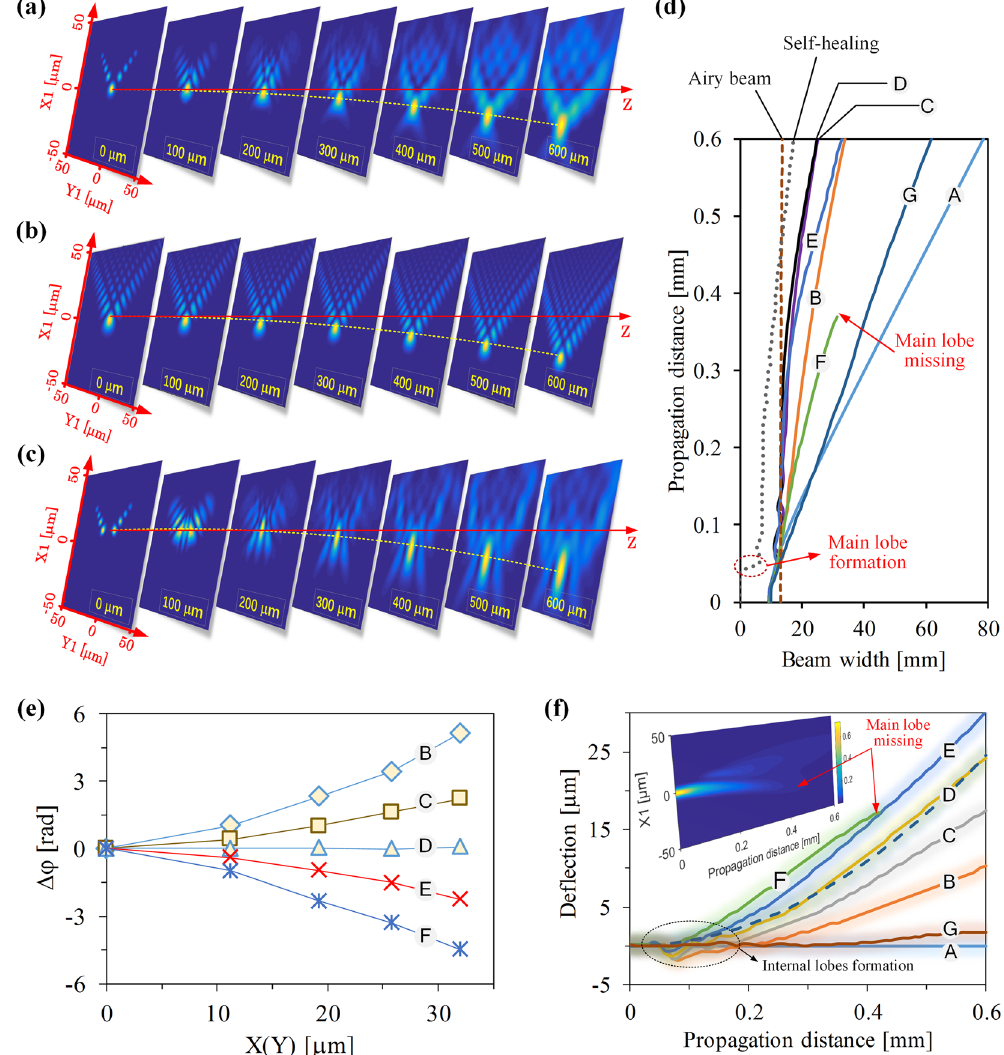
Figure 5. Properties of the output Airy-like beams from different lengths of the Airy fiber. ( a ) The normalized transverse propagation patterns of the output beam from Z D = 2.2 mm length of the Airy fiber. ( b ) The corresponding ideal Airy beam propagation patterns with the same parameters ( m 0 = 5 μ m, m 1 = 4.79 μ m, a m = 0.06, θ m = 0). (c) The self-healing of the Airy-like beam in ( a ) when its main lobe is blocked. ( d ) The main lobe widths of the propagating beams along the Y1-axis. ( e ) The additional phase differences at peak locations of the generated Airy-like beams compared with the ideal Airy beam. ( f ) The corresponding deflection (solid lines) of the main lobe of the generated beams during propagation. The data marked A is corresponding to the input Gaussian beam. And the data marked B, C, D, E, F, and G are corresponding to the output beams from the Airy fibers with lengths Z B , Z C , Z D , Z E , Z F , and Z G , respectively. The dashed lines in ( d and f ) are corresponding to the ideal Airy beams. The inset in (f) indicates the propagation dynamics of the generated Airy-like beam from Z F = 3.68 mm length of the Airy